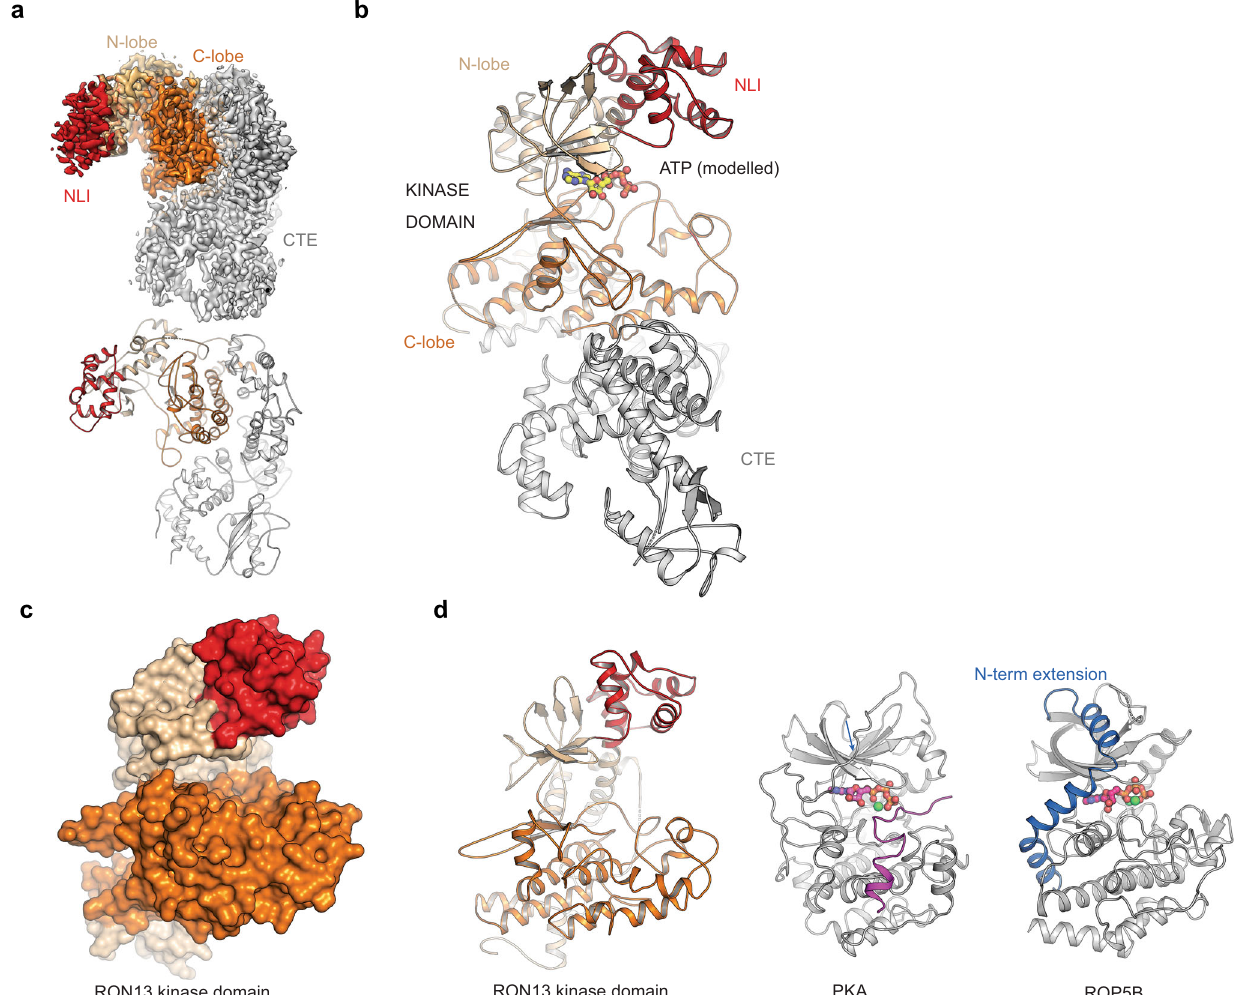
Fig. 4 Structure of RON13. a Cryo-EM density map determined by single-particle analysis at a resolution of 3.1 Å (top), and the corresponding views of the atomic model of rRON13dk. The kinase domain and the C-terminal extension (CTE) are colored in orange and gray tones. b Domain organization of RON13. The position of the ATP-binding site is indicated by the ATP ligand modeled into the active site (absent in the experimentally determined density map). The N-lobe insertion (NLI, red) and the C-terminal extension (CTE, gray) are color-coded. c Surface representation of RON13 kinase domain at 3.1 Å resolution. d Comparison of RON13 kinase domain structure with other kinases. PKA from Mus musculus (PDB ID: 1atp) is complexed with MnATP and an inhibitory peptide (violet). ROP5B from T. gondii bound to ATP (PDB ID: 3q60) contains a ROP-speci fi c N-terminal extension